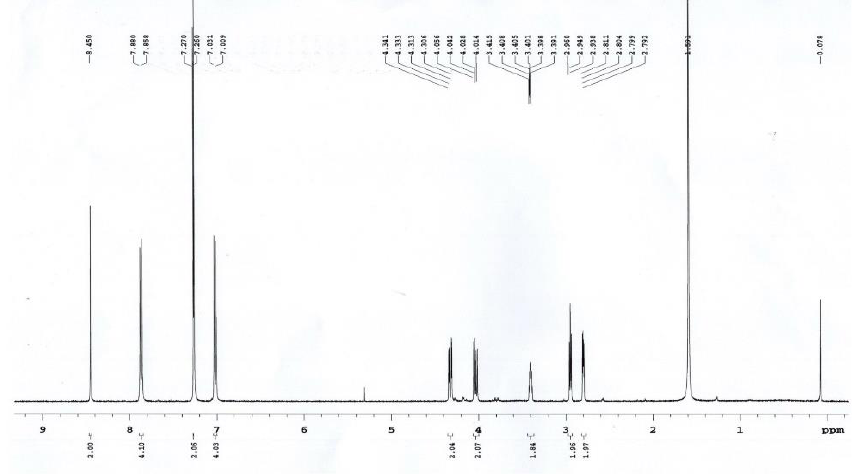
Figure 1. NMR spectra of SBPDAE.